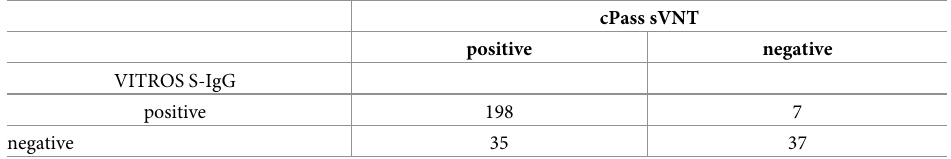
Correlation of VITROS S-IgG and cPass sVNT was evaluated using 277 serum samples: 164 from 64 COVID-19 patients and 113 from 113 vaccinated individuals. P value was evaluated by Spearman’s rank-order correlation coefficient (rho). The vertical axis is in logarithmic